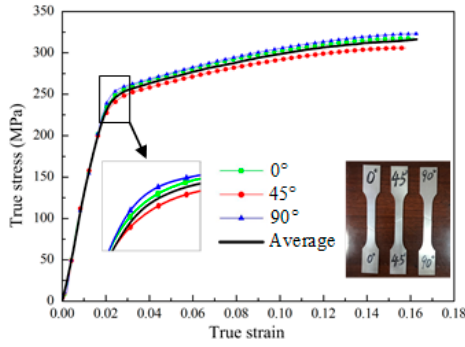
Figure 1. Measured stress–strain curves under di ff erent